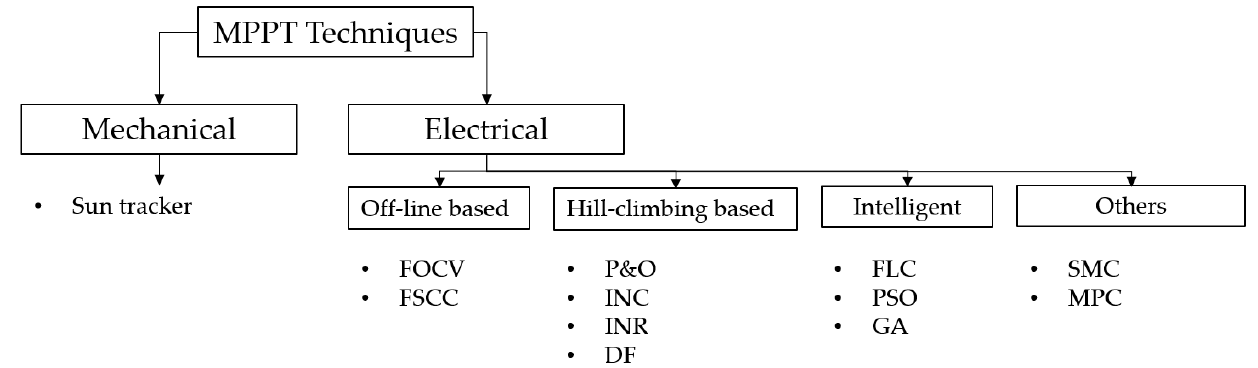
Figure 1. Overview of the analyzed methods in this article.